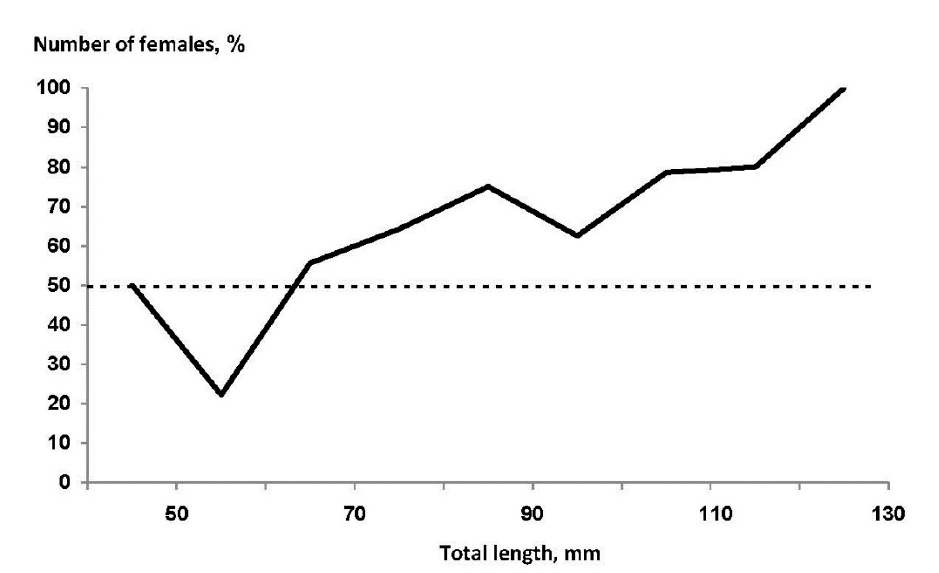
Figure 8. Relative number of females (%) in different sculpin size classes in the Kara Sea, September 2019. Table 3. Changes of individual fecundity of ribbed sculpin Triglops pingelii in the Kara Sea with increase of total length, body weight, and age (SE = standard error).